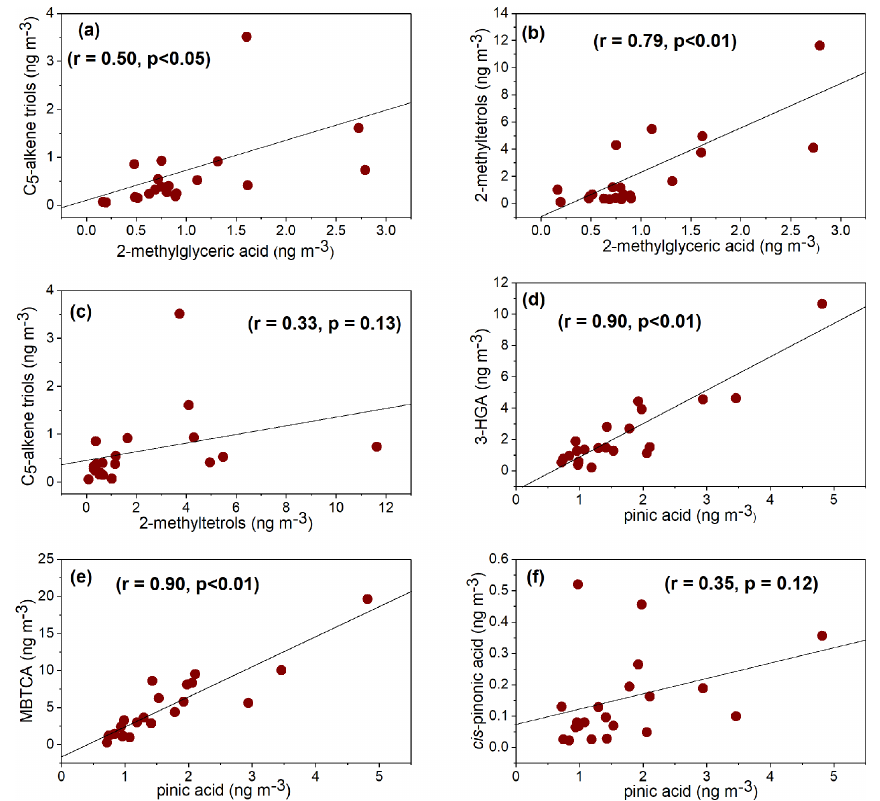
Figure 6. Pearson linear correlation coefficient analysis of BSOA tracers in Gosan TSP aerosols during April 2013–April